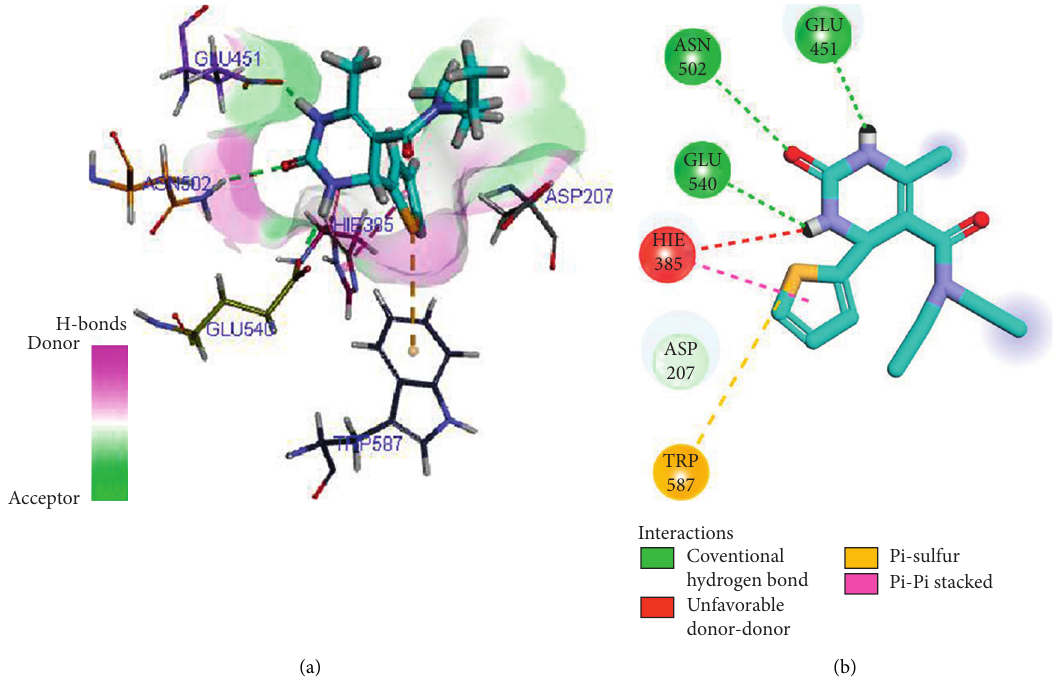
Figure 4: Interaction pattern of compound 4i inside the β -glucuronidase enzyme. 3D interactions of ligand within a hydrogen bond protein surface (a) and 2D interactions (b) figures were generated by Discovery Studio Visualizer